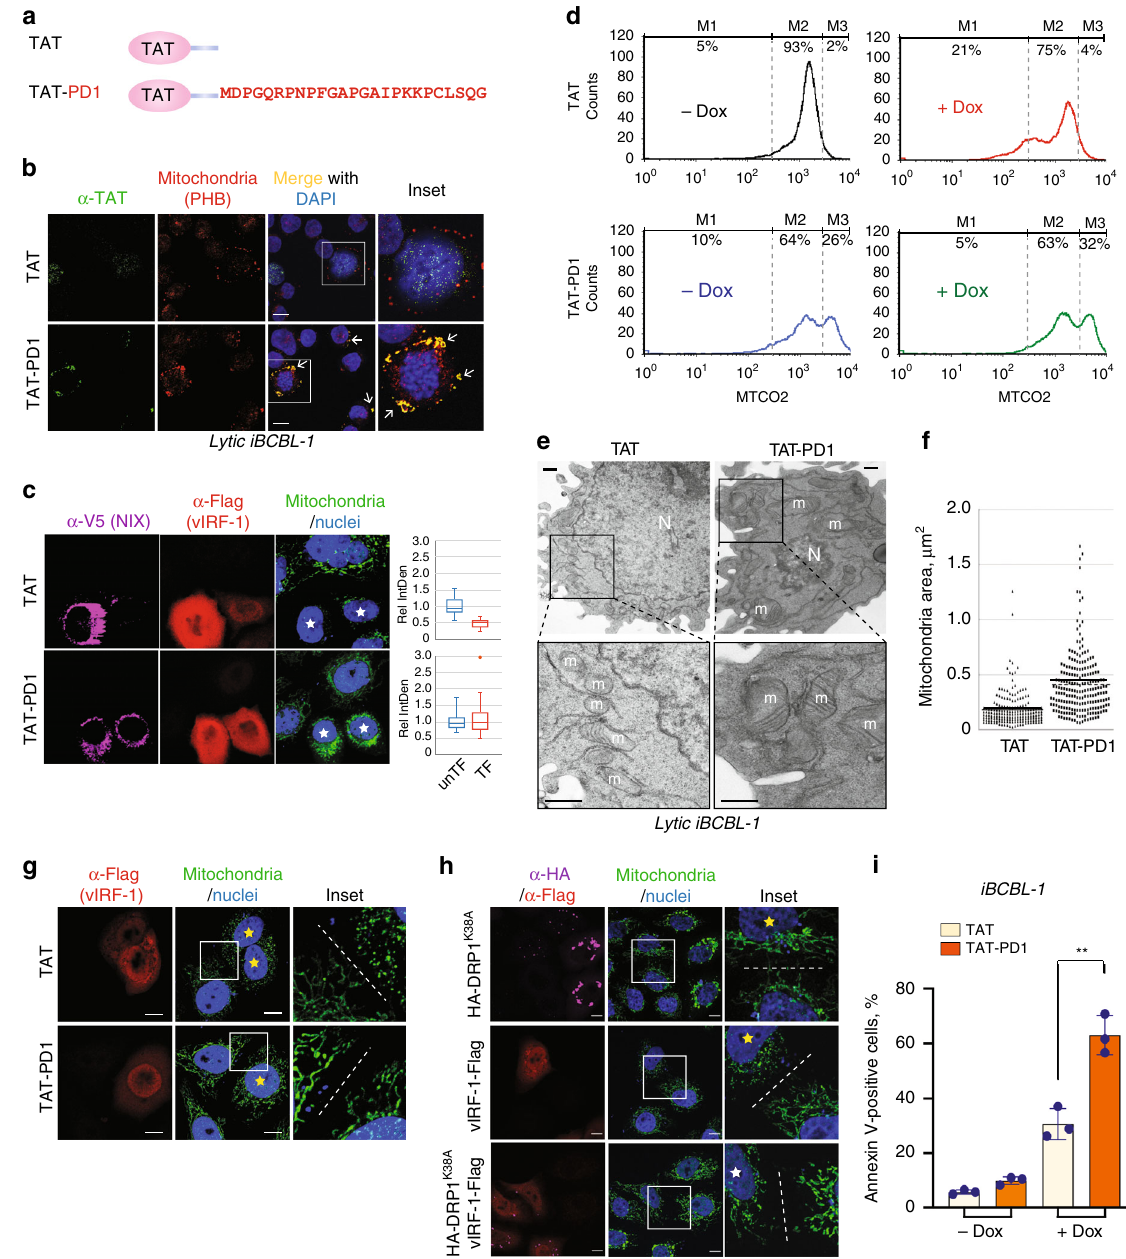
Fig. 7 A vIRF-1 peptide impairs mitophagy and mitochondrial dynamics. a TAT and TAT-fused PD1 (TAT-PD1) peptides. PD1 consists of the N-terminal vIRF-1 residues 1 to 25. b IFA analysis of intracellular delivery of the TAT peptides. iBCBL-1 cells were treated with 10 µ M TAT or TAT-PD1 peptide together with Dox for 2 days and immunostained with anti-TAT and prohibitin (PHB, mitochondrial marker) antibodies. White arrows indicate co-localization of TAT-PD1 with mitochondria. Scale bar, 10 µ m. c IFA analysis of TFAM of HeLa.Kyoto cells that were transfected with V5-NIX and vIRF-1-Flag and then treated with 20 µ M TAT or TAT-PD1. Relative IntDen was calculated by dividing by unTF control, and the distribution of data is shown in the boxplots that display the full range of variation (whiskers), the likely range of variation (box), the median (center line), and the outlier (dot). d Flow cytometric analysis of MTCO2 of iBCBL-1 cells that were treated with 10 µ M TAT or TAT-PD1 together with or without Dox for 2 days. e , f Electron microscopy analysis of lytic iBCBL-1 cells (Dox for 2 days) treated with 10 µ M TAT or TAT-PD1. m indicates mitochondria and N indicates nucleus. Scale bar, 500 nm. Mitochondria areas were determined using ImageJ software and are depicted on the dot graph ( f ). The numbers of mitochondria and cells measured: n = 187, 20 cells for TAT and n = 208, 26 cells for TAT-PD1. g IFA analysis of mitochondria (TFAM) of HeLa.Kyoto cells transfected with vIRF-1-Flag and treated with 20 µ M TAT or TAT-PD1 for 24 h. Scale bar, 5 µ m. h IFA analysis of mitochondria (TFAM) of HeLa.Kyoto cells transiently transfected with a dominant negative form of DRP1 (HA-DRP1 K38A) and/or vIRF-1-Flag for 24 h. Singly and dually transfected cells are highlighted in yellow and white stars, respectively. Dotted lines distinguish between transfected and untransfected cells. Scale bar, 5 µ m. i Flow cytometric analysis of Annexin-V binding to iBCBL-1 cells treated with 10 µ M TAT or TAT-PD1 (± Dox for 2 days). Each value represents the mean of three independent experiments ± SD . The p -value was determined by matched pair t -test (** p < 0.01). Source data are provided as a Source Data fi